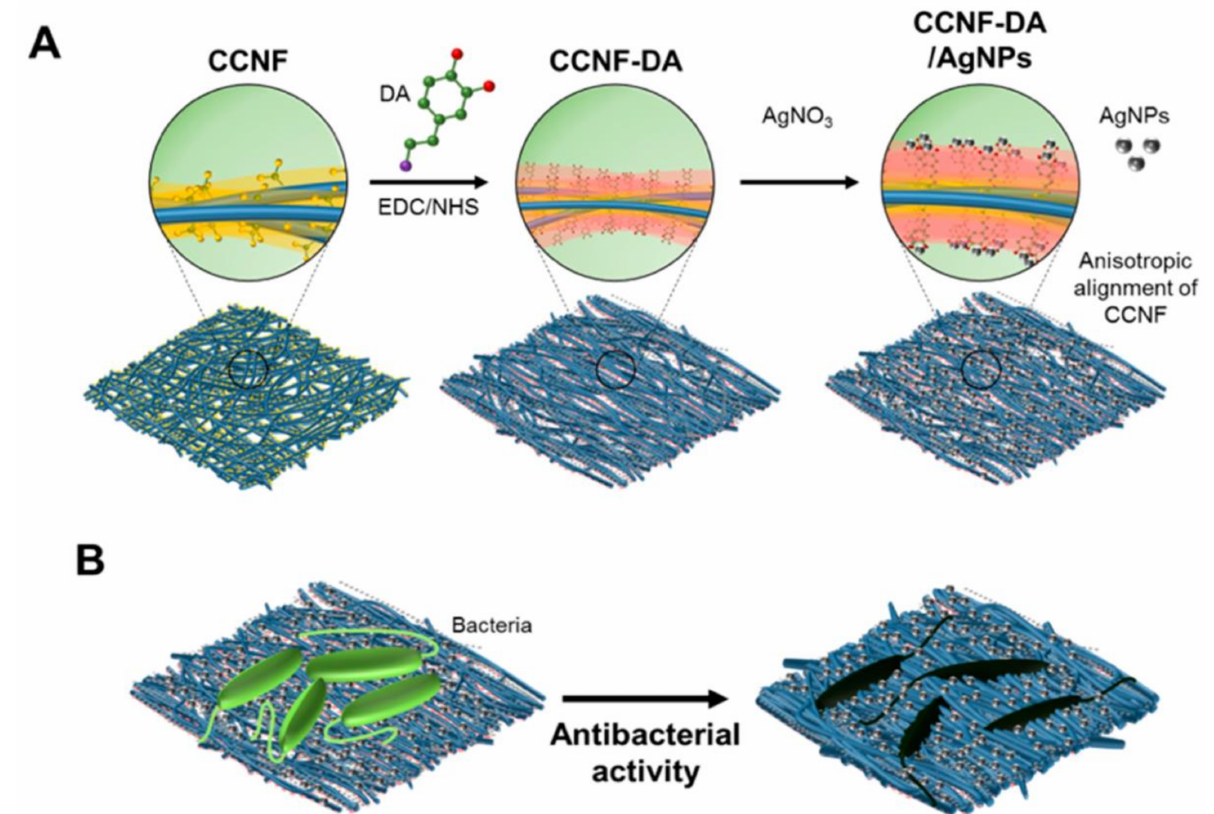
Figure 13. Schematic description of ( A ) anisotropic carboxylated cellulose nanofiber (CCNF)-dopamine (DA)/silver nanoparticle (Ag NPs) composite formation using 1-ethyl-3-(3-dimethylaminopropyl)carbodiimide (EDC) and N- hydroxysuccinimide (NHS); and ( B ) antibacterial activity of the CCNF-DA/Ag NP composite [258]. Reproduced with permission from Nguyen et al. (2016) © MDPI [Open